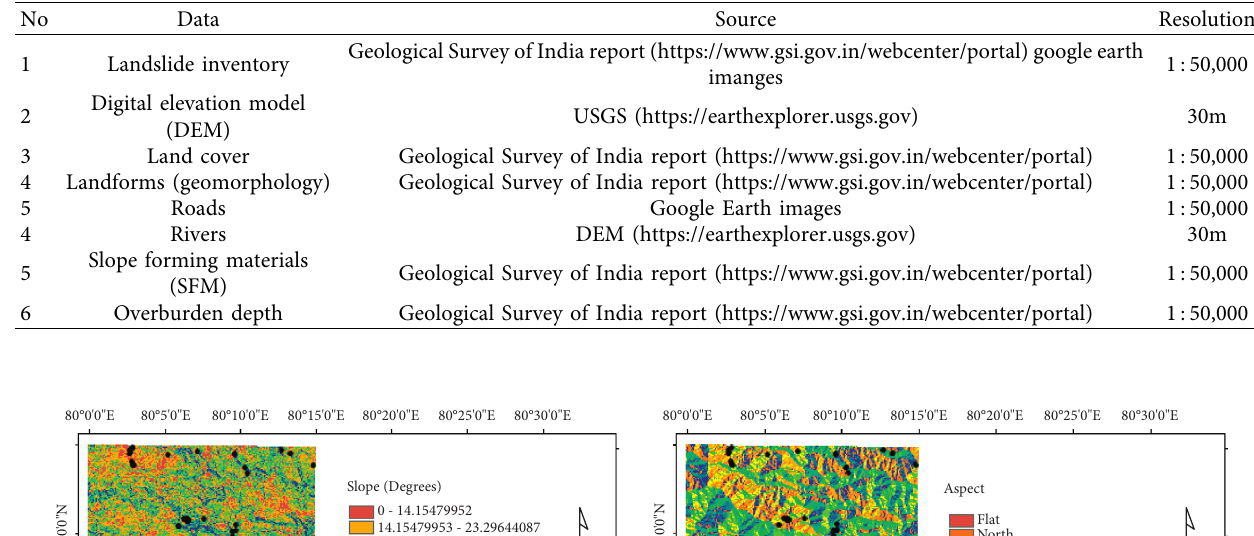
Table 1: Data used in this study.